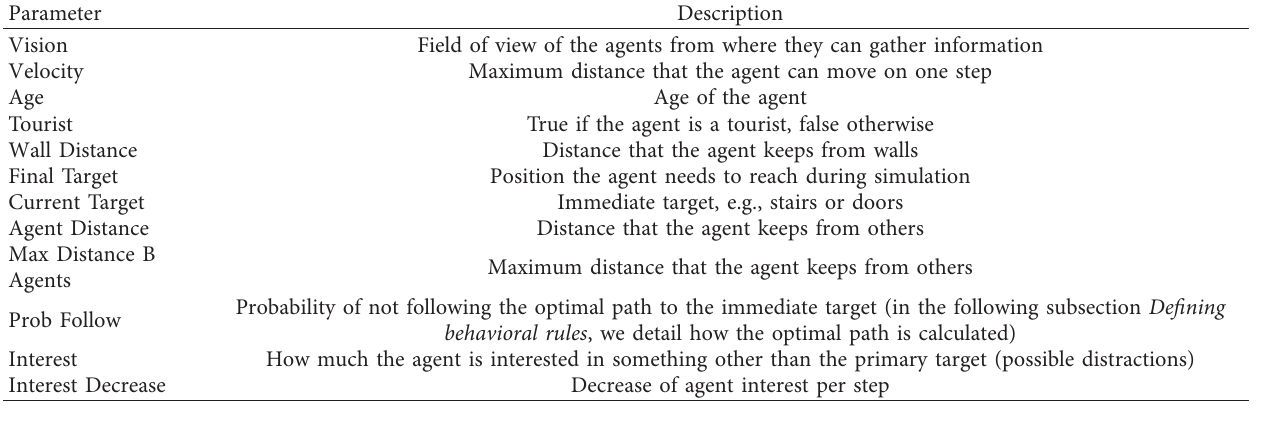
Table 1: Agent parameters in Pandora.